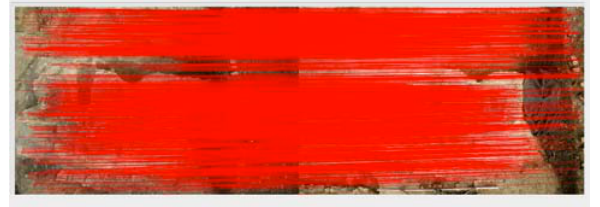
Figure 4. Tie Point extraction using MicMac